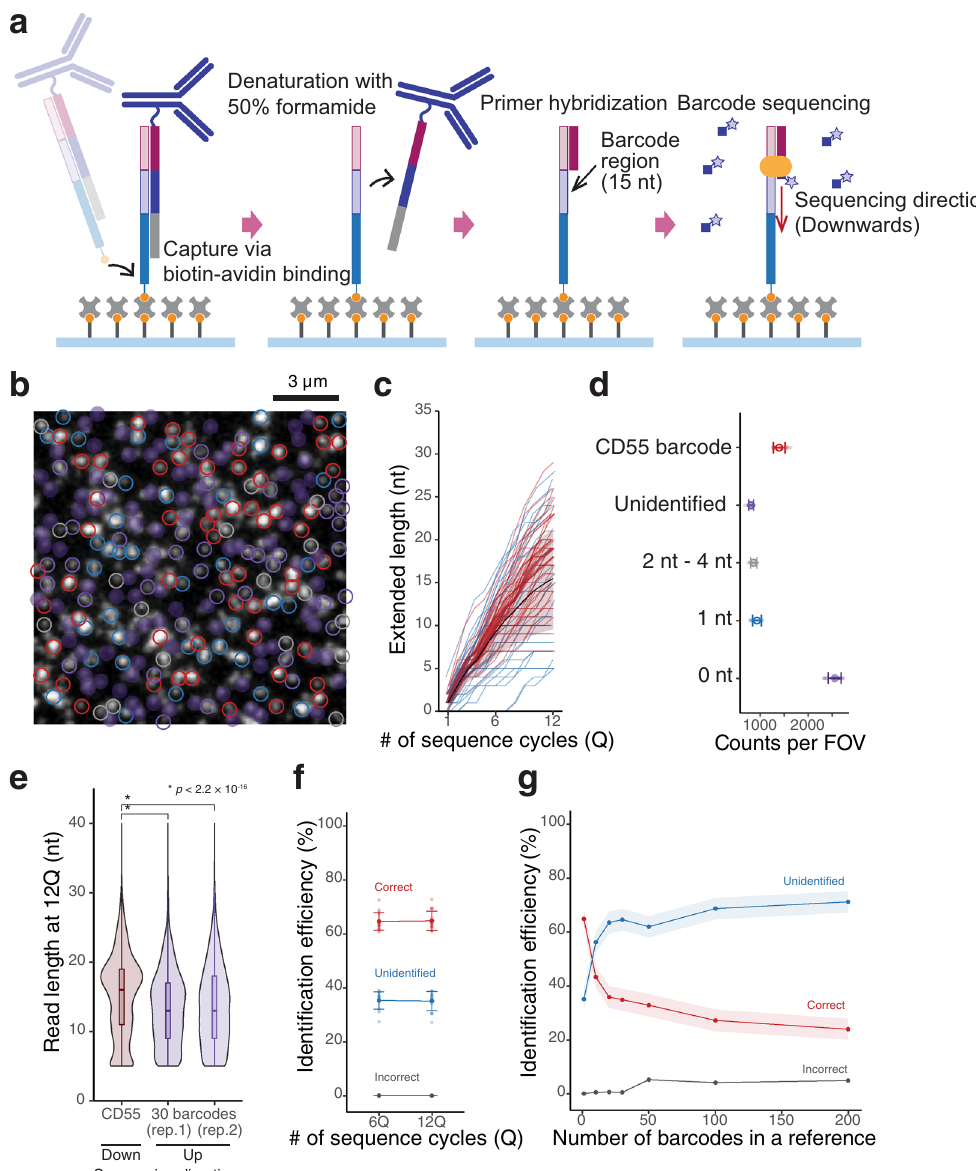
Fig. 4 Visualization and identi fi cation of DNA barcoded antibodies at single-molecule resolution. a Schematic illustrations showing a procedure of sequencing of DNA barcoded antibody (Ab-Oligo) on our system. b A fl uorescence image of individual CD55 Ab-Oligos visualized by the 1st virtual terminator incorporation. Scale bar represents 3 μ m. Molecules identi fi ed as single fl uorescence spots via image analysis are encircled with colors corresponding to those shown in d . c Extension traces of individual molecules; reads <5 nt were excluded. Each trace represents the extension of each molecule shown in b . d Average number of identi fi ed barcode molecules per FOV. Error bars represent SD ( N = 16). Note that for analyses shown in b – d , f reference to identify individual reads contained only CD55 barcode sequences. e Comparison of read lengths between different sequencing directions. f Comparison of identi fi cation ef fi ciency between 6Q and 12Q. g Estimation of multiplexing ability. False positive identi fi cation (incorrect) was calculated by changing the number of barcode sequences in the reference (1 – 200 types of sequences). Up to 30 types in a reference, false